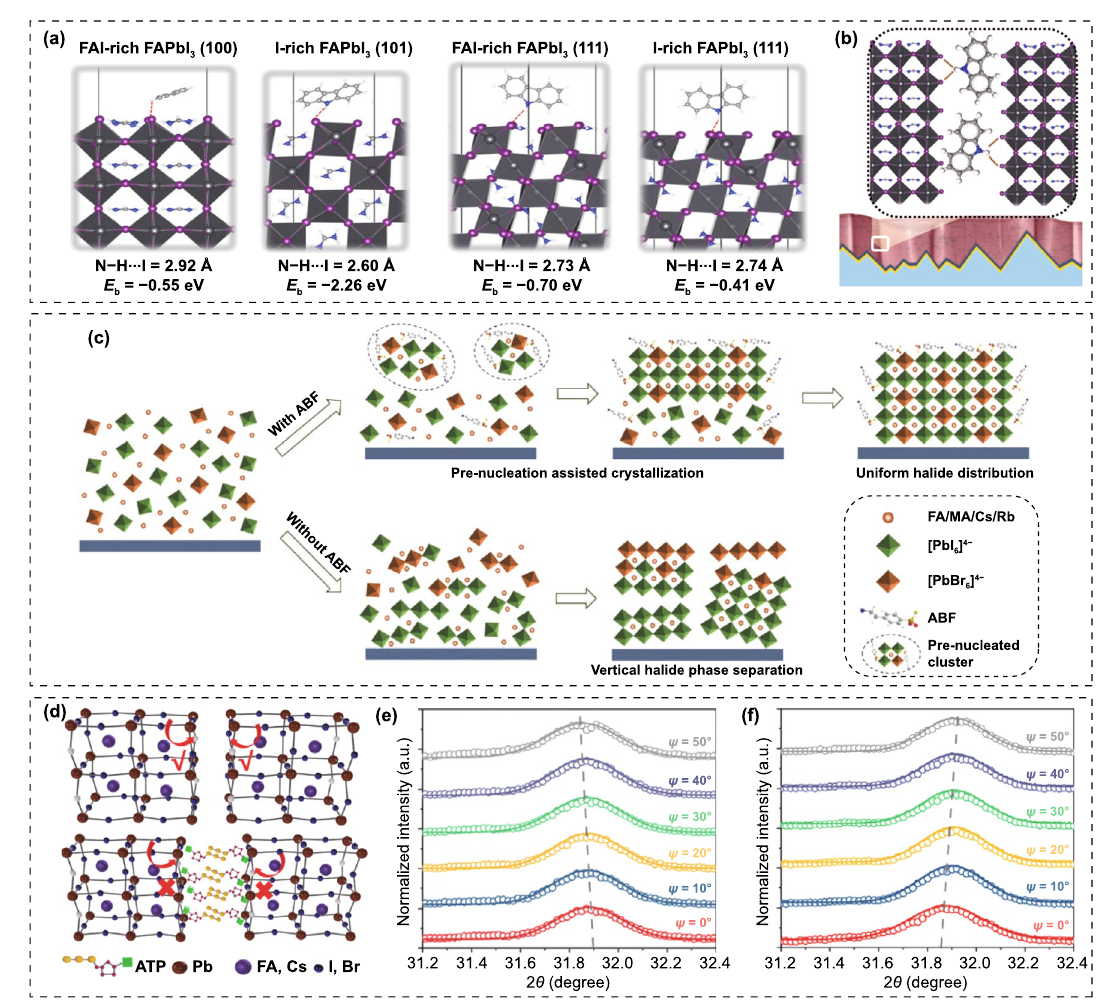
Fig. 9 a Optimized interfacial structures for carbazole/FAPbI 3 models with different surface orientations and terminations of FAPbI 3 , together with hydrogen bond lengths (red dashed lines) and binding energies ( E b ) between carbazole and perovskite. b Schematic illustration of inter- action of carbazole with perovskite films. Reproduced with permission from Ref. [156]. Copyright 2021, Elsevier. c Schematic diagram of ABF pre-nucleation assisted crystallization process. Reproduced with permission from Ref. [157]. Copyright 2022, Wiley–VCH. d Schematic describing of interaction between ATP and perovskite. e XRD spectra in (001) planes of REF and ATP films before and after light soaking for 2 h. f W–H analysis for REF and ATP films before and after light soaking. Reproduced with permission from Ref. [69]. Copyright 2022, Wiley–